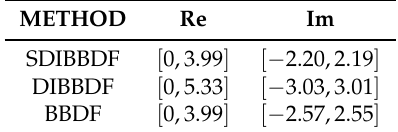
Table 1. Interval of unstable area on real and imaginary